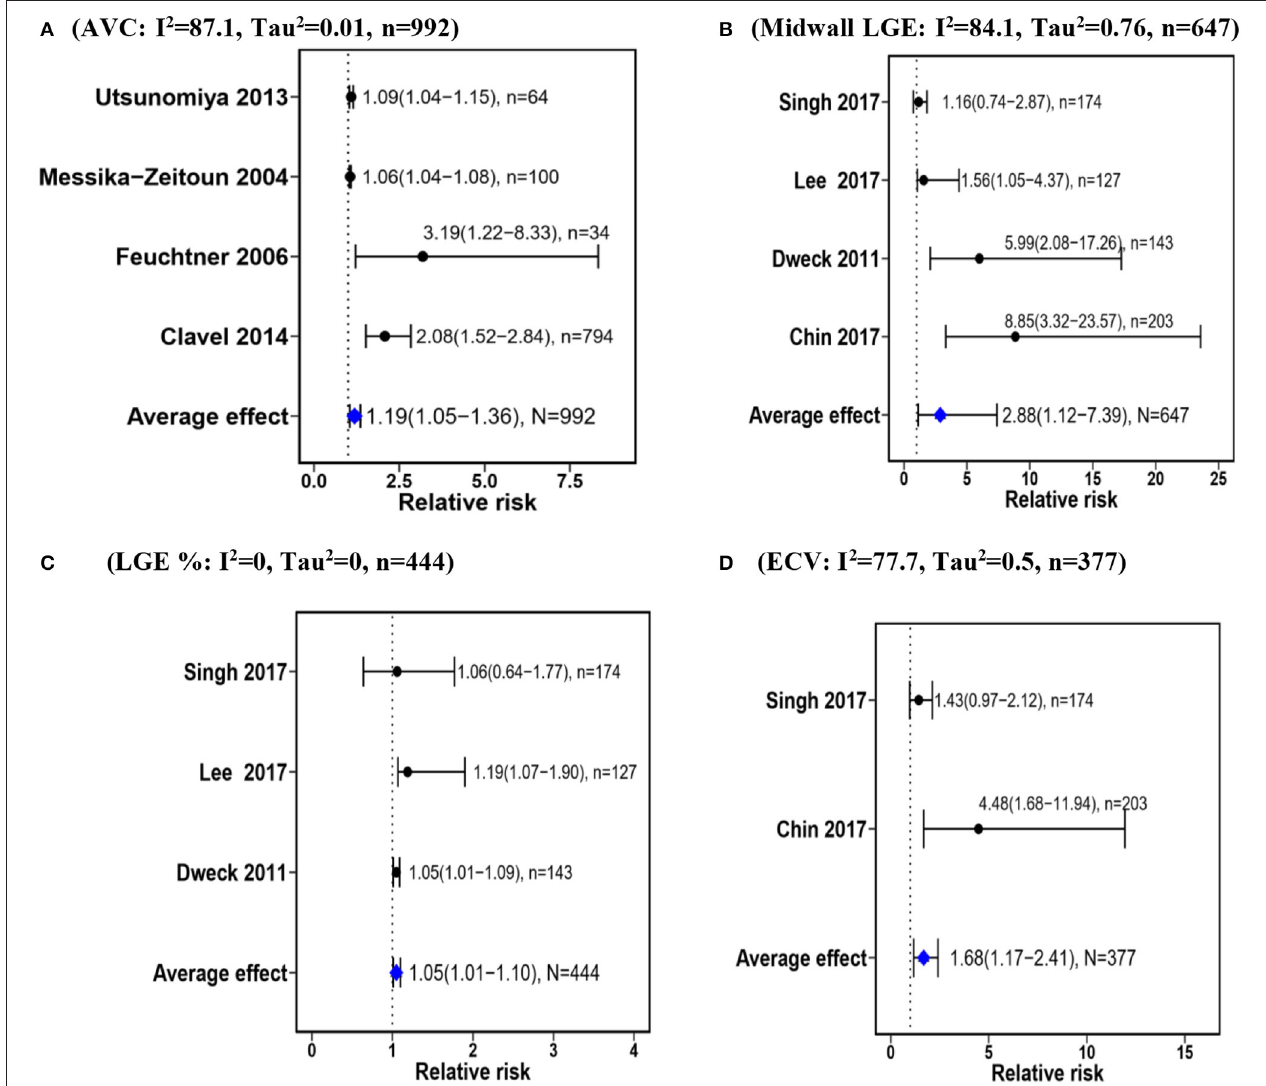
FIGURE 2 | Forest plots showing the average relative risks for the strength of association between imaging biomarkers and outcomes in AS. AVC, aortic valve calcification; LGE, late gadolinium enhancement; ECV, extracellular volume. (A) (AVC: I 2 = 87.1, Tau 2 = 0.01, n = 992). (B) (Midwall LGE: I 2 = 84.1, Tau 2 = 0.76, n = 647). (C) (LGE %: I 2 = 0, Tau 2 = 0, n = 444). (D) (ECV: I 2 = 77.7, Tau 2 = 0.5, n =